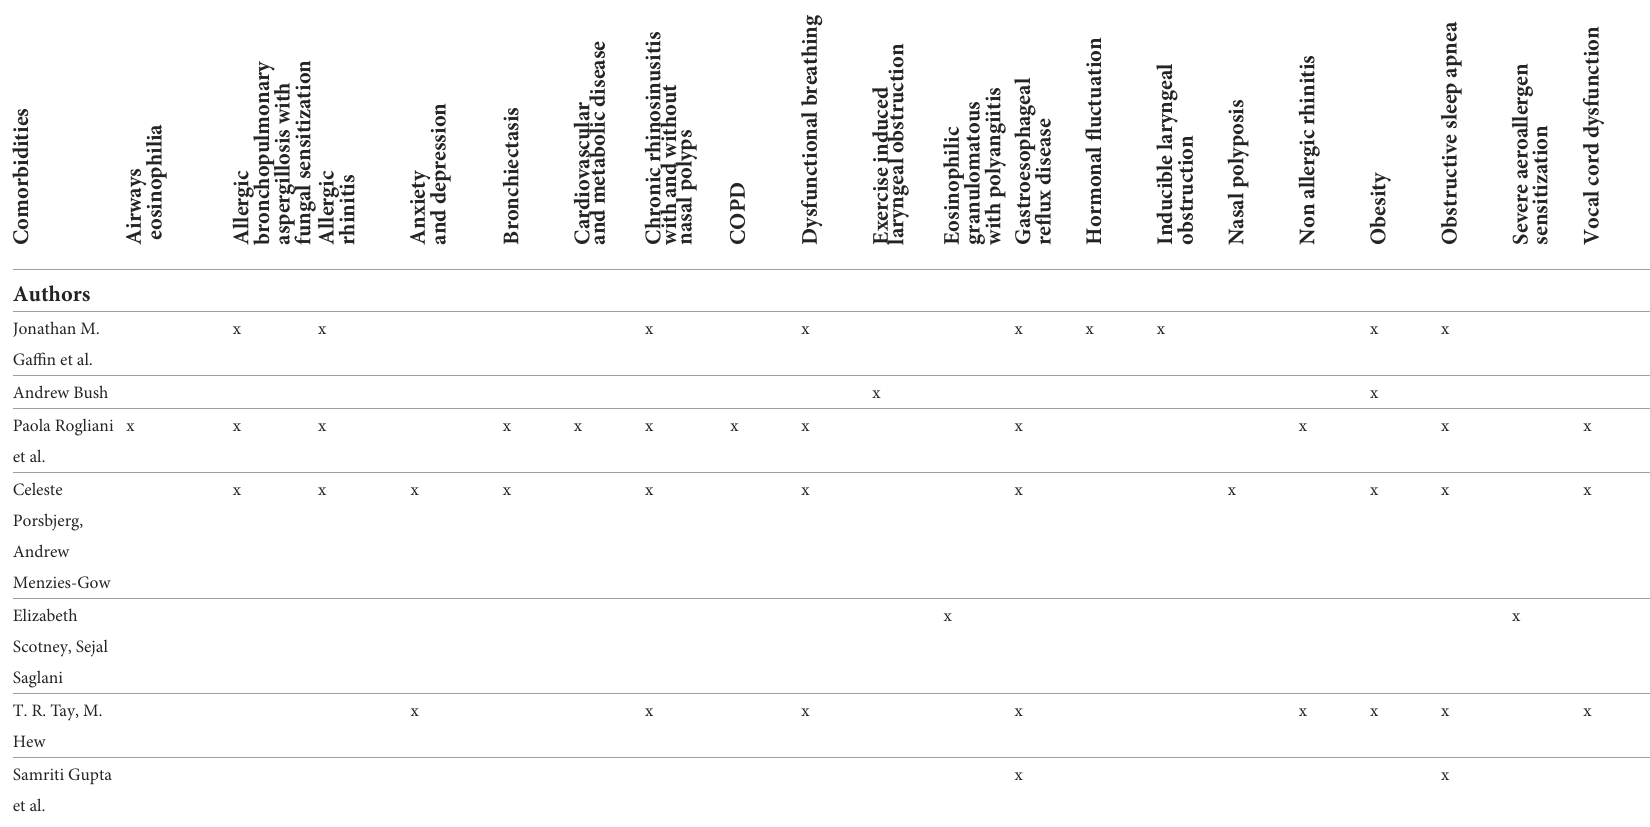
TABLE 1 Main articles reporting comorbidities in pediatric severe